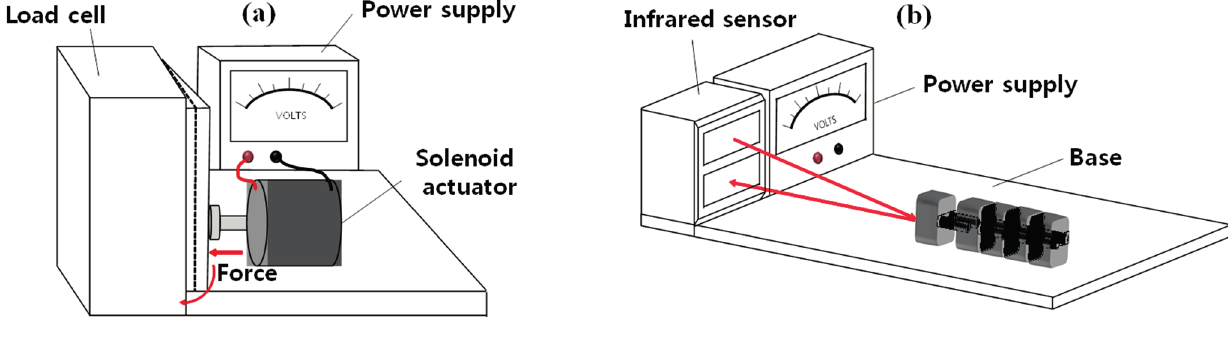
Figure 6. Experimental apparatus: ( a ) the measurement of the output force by the solenoid actuator; ( b ) the displacement measurement of the segmented robot using an infrared